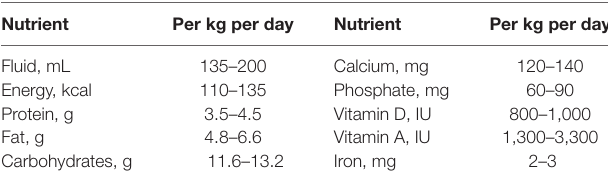
TaBLe 3 | Recommended enteral nutrient intakes for preterm infants.